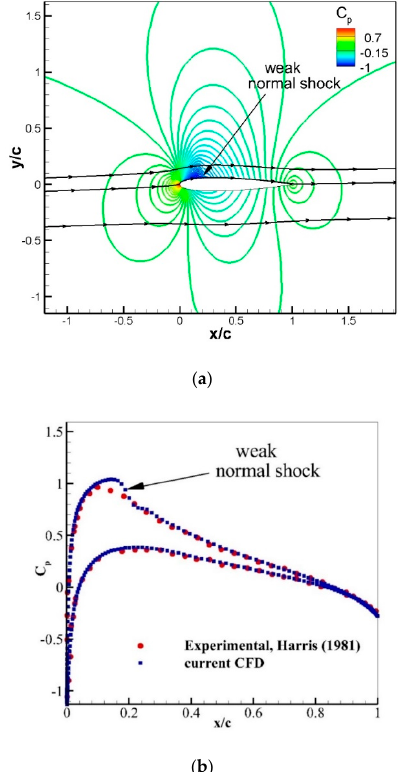
Figure 8. ( a ) Coe ffi cient of pressure contours and ( b ) surface pressure coe ffi cient for the NACA0012 Figure 8. ( a ) Coefficient of pressure contours and ( b ) surface pressure coefficient for the NACA0012 airfoil at Mach = 0.7 and Re (cid:2998) = 9 × 10 6 at an angle of attack = 1.5° compared with the experimental airfoil at Mach = 0.7 and Re ∞ = 9 × 10 6 at an angle of attack = 1.5 ◦ compared with the experimental data [23]. data